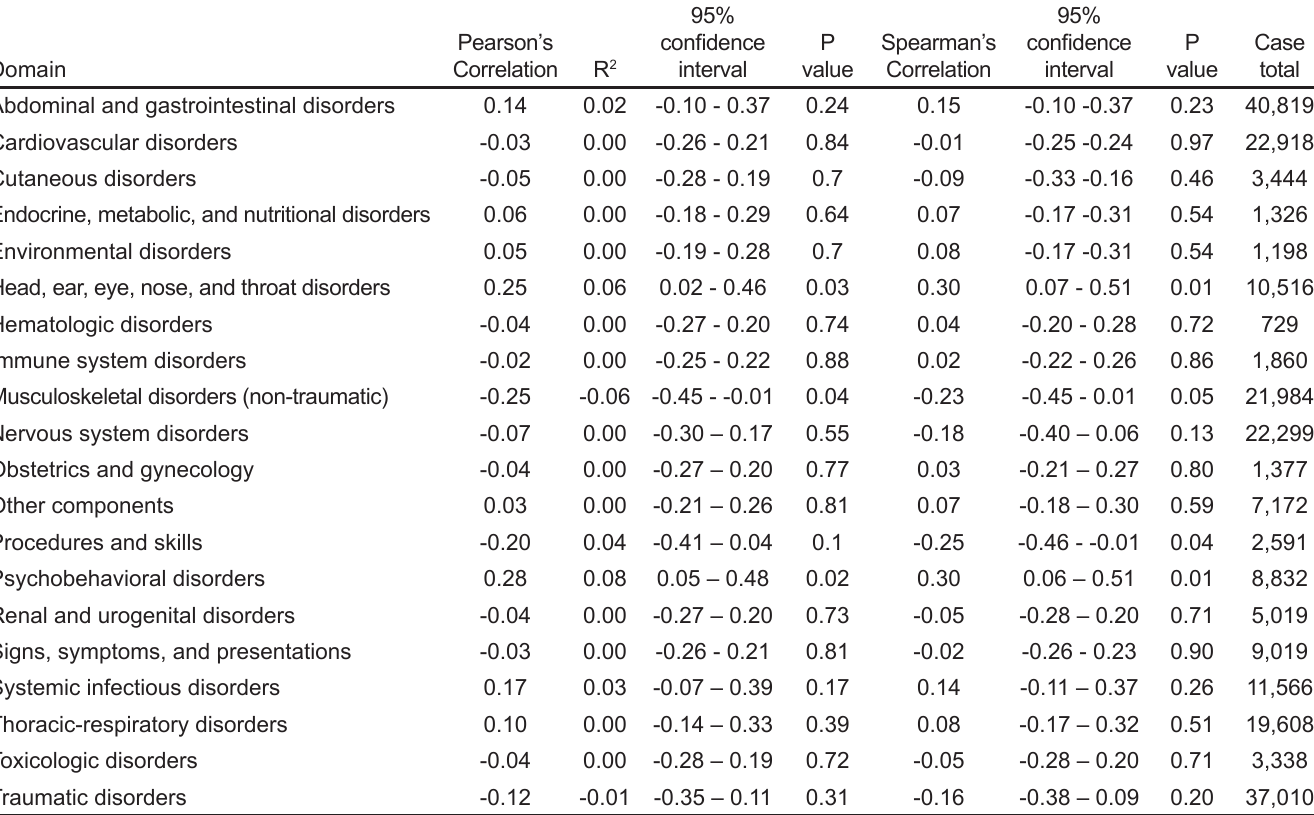
Table 2. Correlations between number of patient encounters and in-training exam scores for each of the American Board of Emergency Medicine Model of Clinical Practice